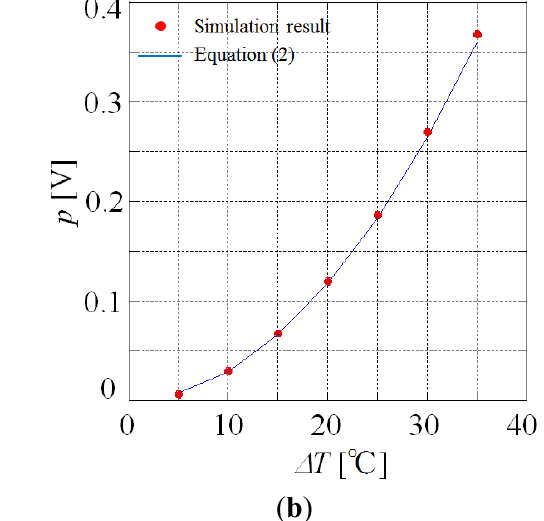
Figure 10. Simulation results of V ( b )  T - p